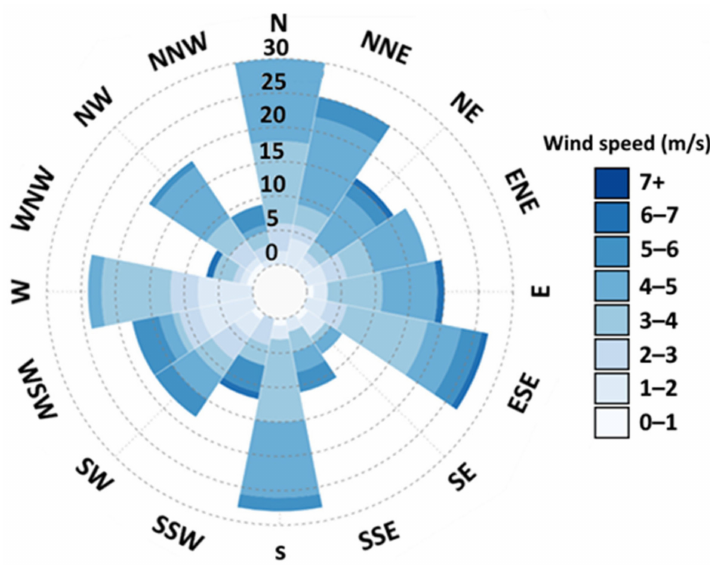
Figure 7. Wind rose at Hail University (10 m above ground